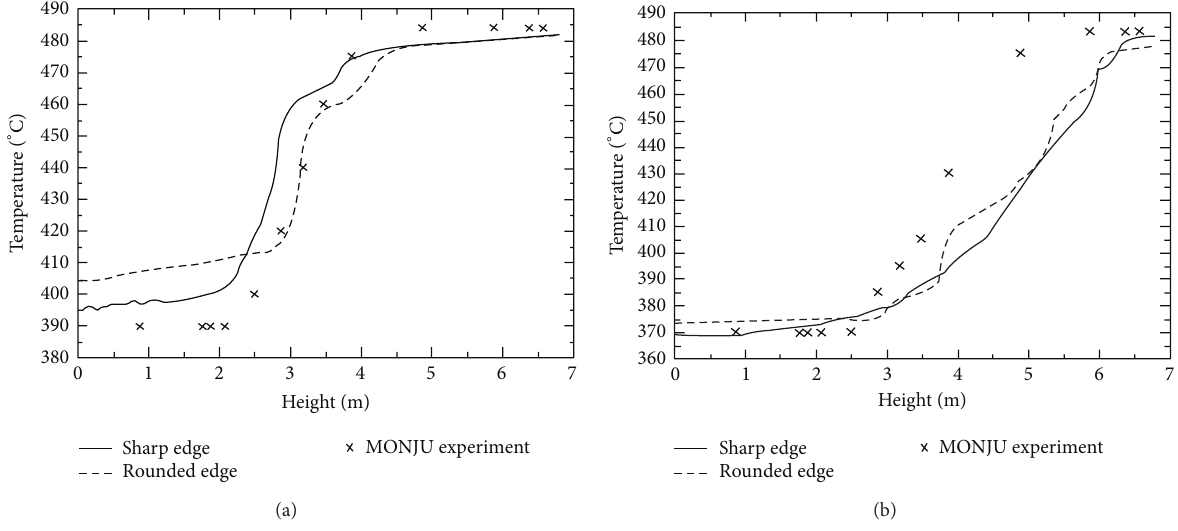
Figure 8: (a) Axial temperature profiles at 𝑡 = 2 min. (b) Axial temperature profiles at 𝑡 = 10